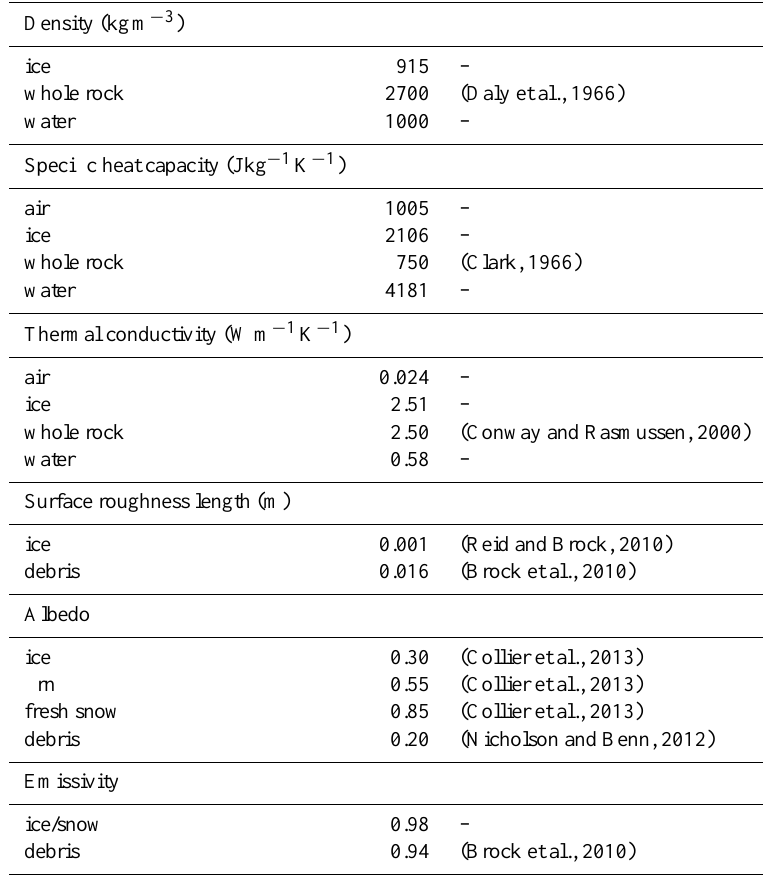
Table 3. Physical properties in the CMB